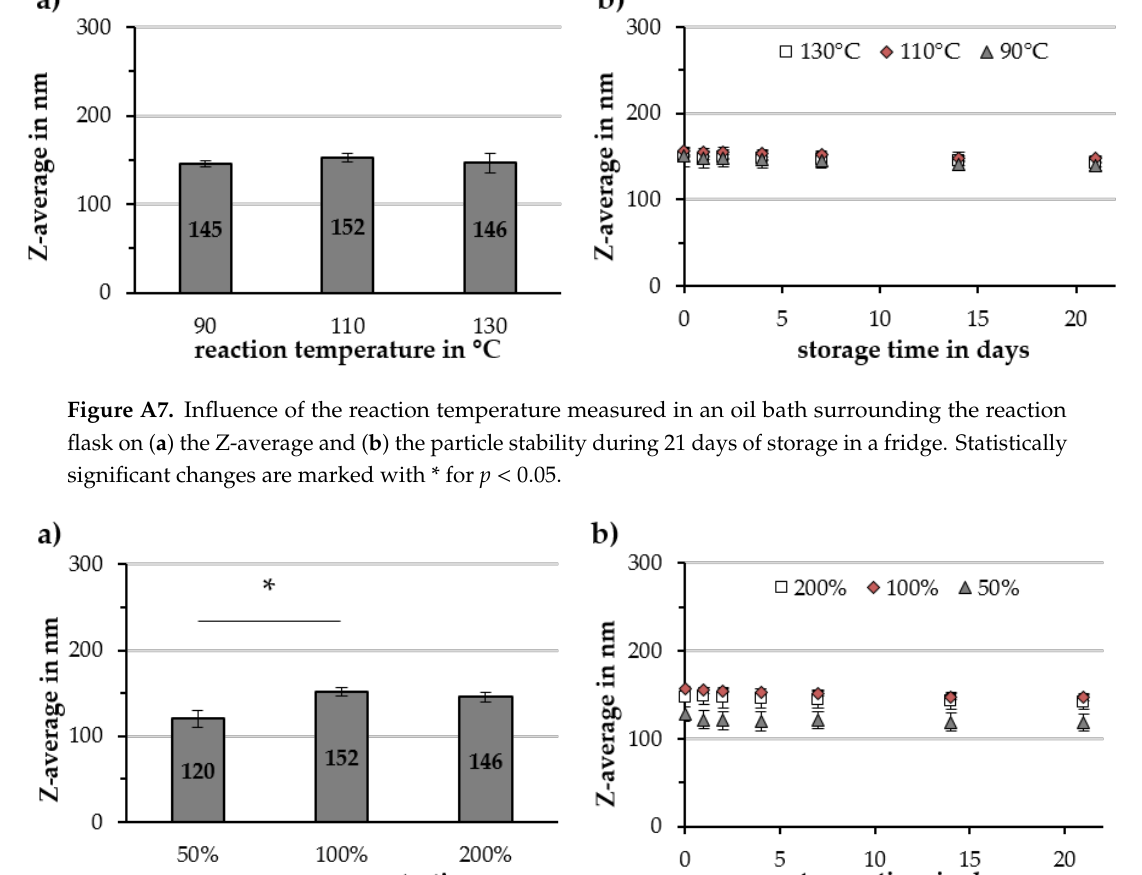
Figure A7. Influence of the reaction temperature measured in an oil bath surrounding the reaction flask on ( a ) the Z-average and ( b ) the particle stability during 21 days of storage in a fridge. Statistically significant changes are marked with * for p < 0.05. Table A1. Comparison of the parameters of Cit-Au-SPIONs with varied reaction temperatures. Reaction Temp.